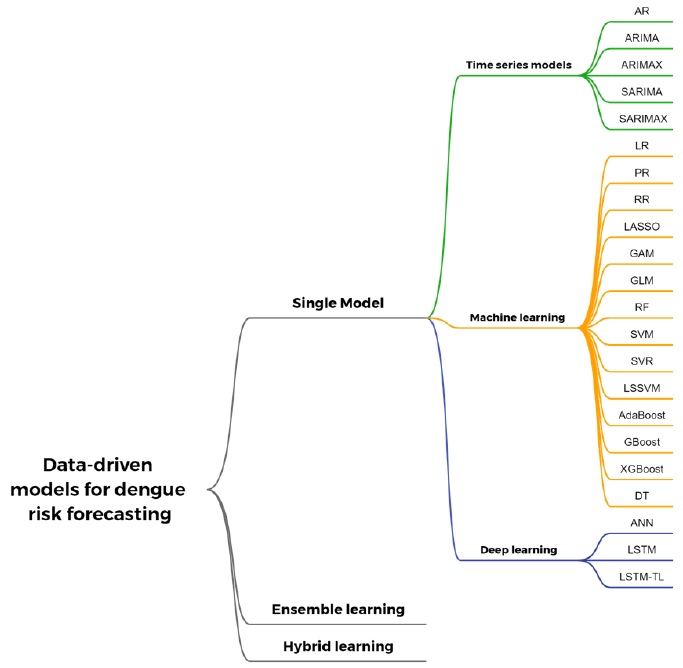
Figure 6. The categories of predominate dengue risk forecasting models used in recent studies, with a minimum number of model occurrences of 2.